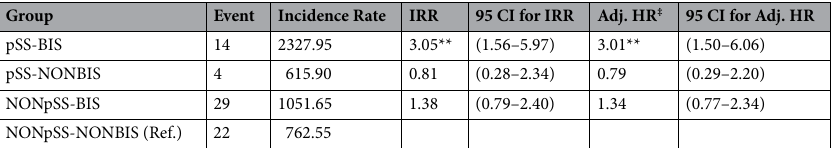
Table 4. Interaction analysis between pSS and anti-osteoporosis drugs users in Case 3. (1) *0.01 ≤ p < 0.05, **0.0001 ≤ p < 0.01, *** p < 0.0001. (2) ‡ ADJ. HR was adjusted by sex, comorbidities, and age at the initiation of